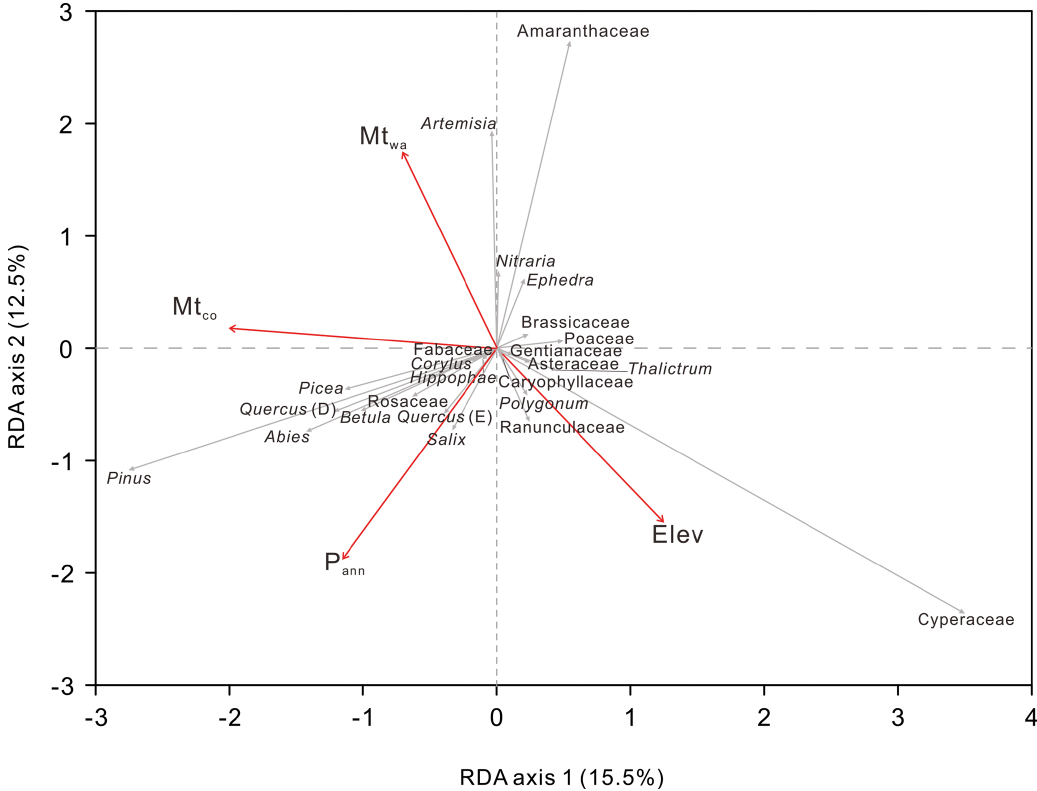
Figure 3. Redundancy analysis (RDA) of modern pollen samples along with three climate variables and elevation.